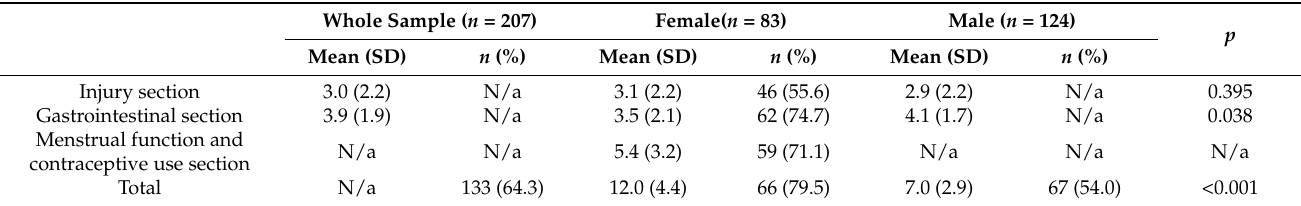
Table 2. Sum score and prevalence of athletes at risk for each section and total Low Energy Availability in Females Questionnaire